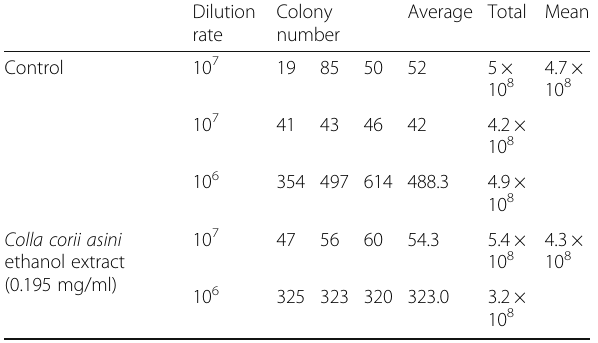
Table 3 Determined the maximum concentration of Colla corii asini ethanol extract (no effect on bacterial